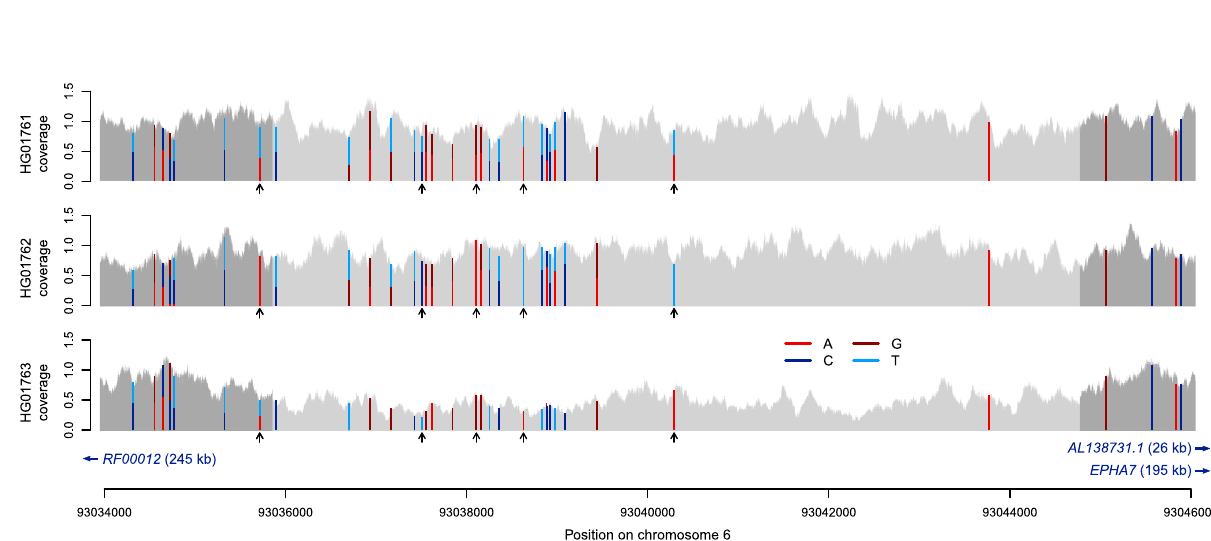
Fig. 6 De novo deletion identi fi ed by PopDel in one individual of the Polaris Kids cohort. The child (HG01763) is a carrier of a heterozygous deletion (indicated by the light gray interval) that is not present in either parent. Black arrows mark SNPs that allow phasing of the haplotypes in the